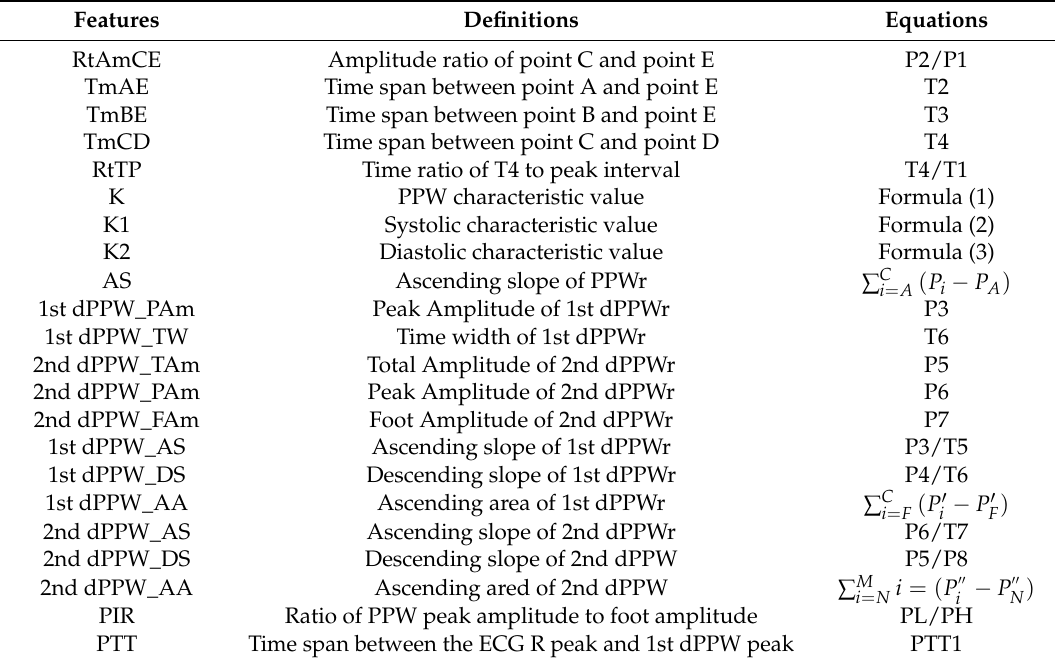
Table 2. Definitions of the selected features in